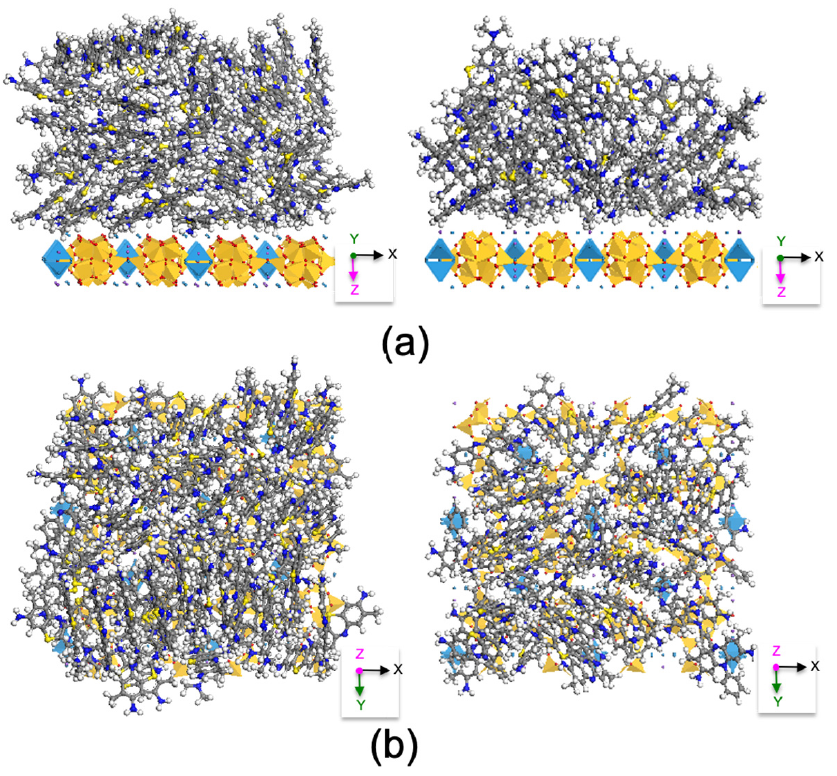
Figure 10. Molecular dynamic simulation showing TB uptake ( left ) and TB + SO ( right ) on the {001} surface projected along crystallographic b ( a ) and c ( b ) directions of ZEO.